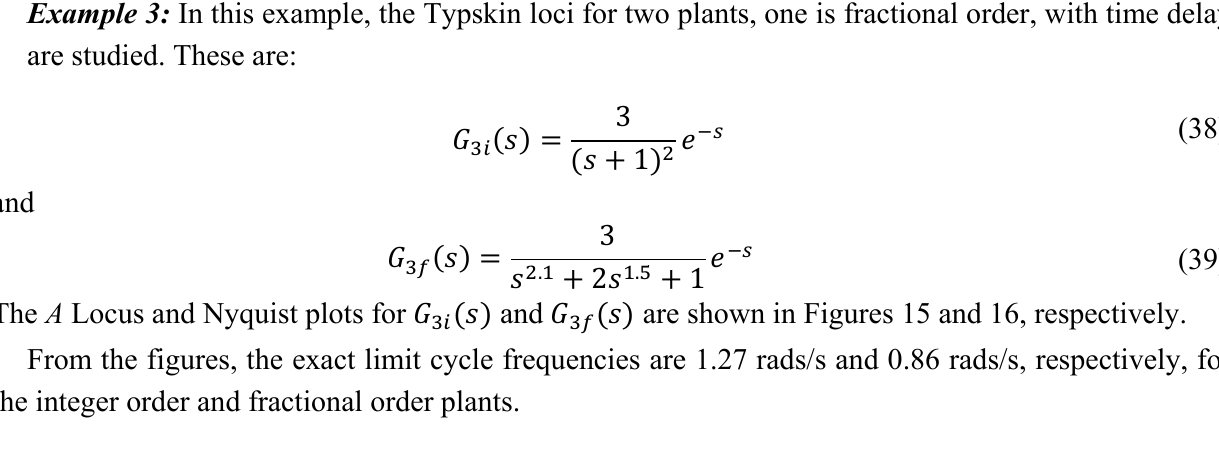
is an ideal 𝑁(𝑎)